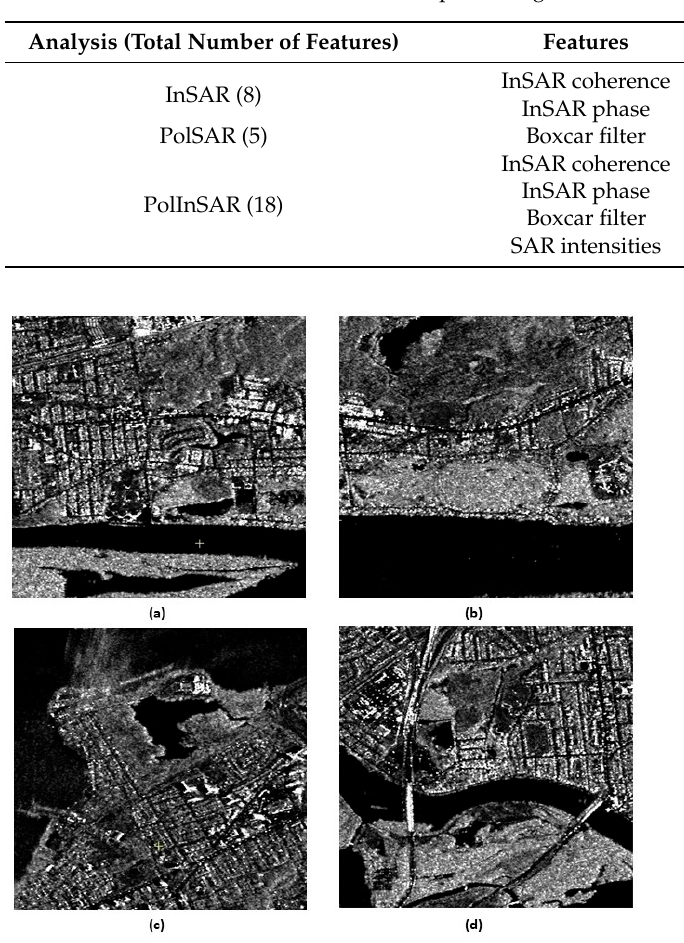
Table 2. Generated features from PolInSAR processing over each area.